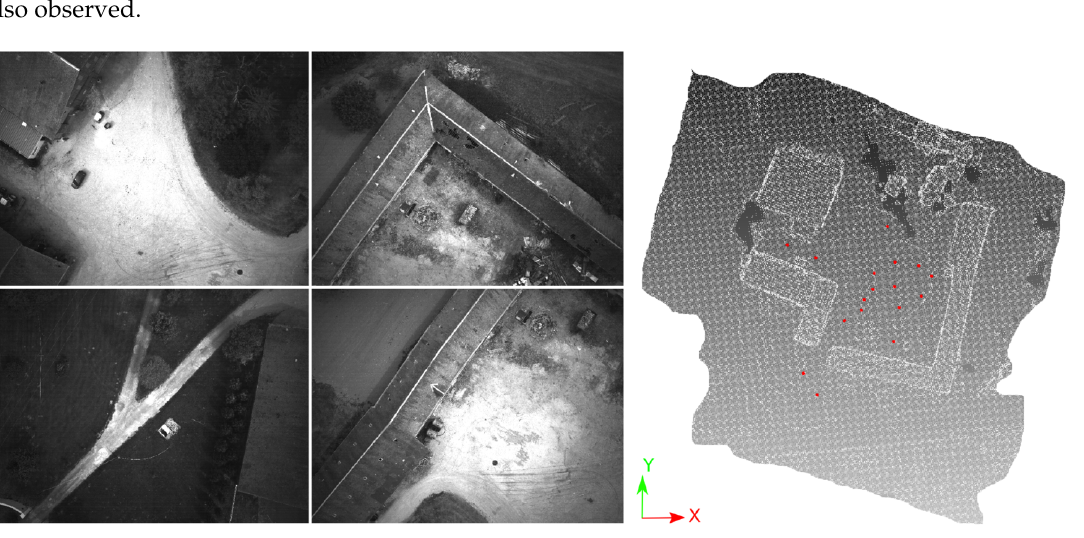
Figure 26. The Viabon 1